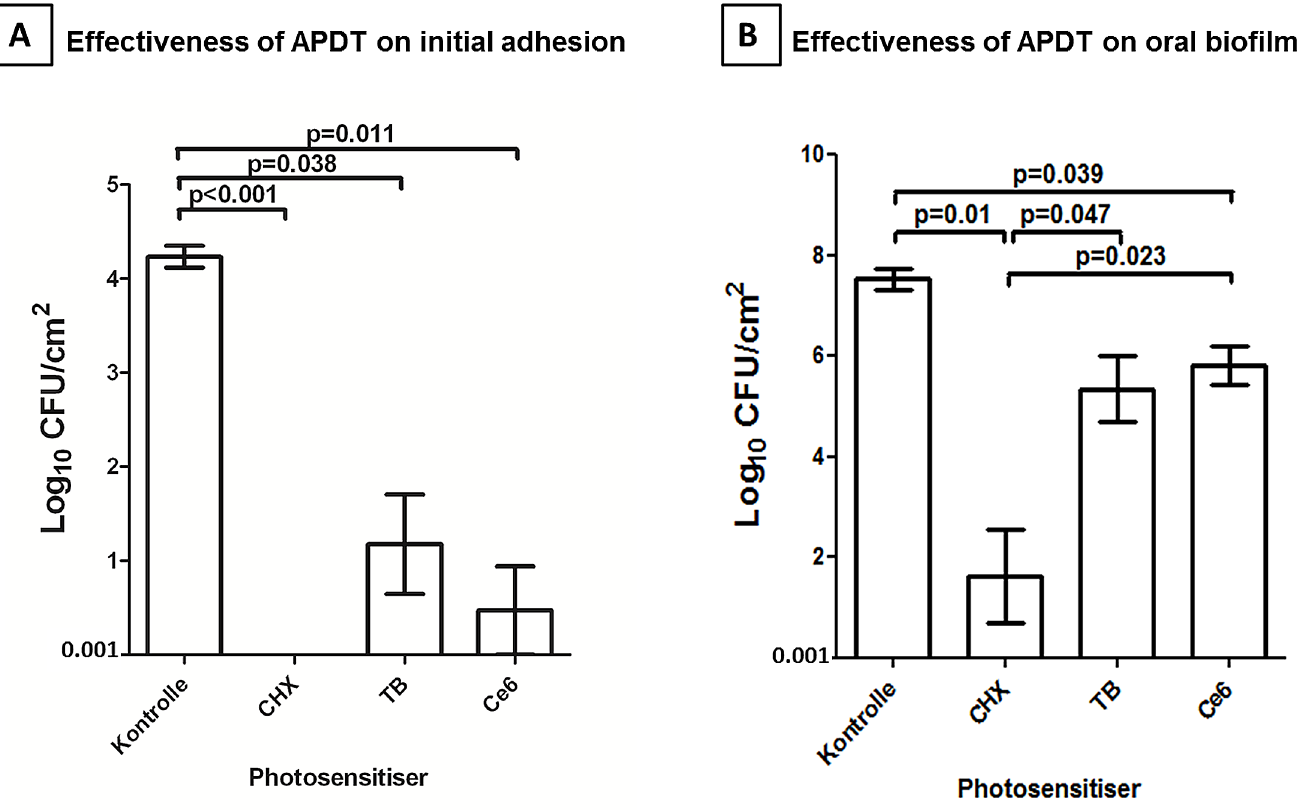
Fig 3. Diagram of the colony forming units (CFUs) depicting the effect of photodynamic therapy using visible light (VIS) plus water-filtered infrared-A (wIRA) against oral microorganisms during initial adhesion (A) and biofilm formation (B), respectively. The photosensitizers toluidine blue (TB) and chlorine e6 (Ce6) were applied (100 μ g/ml) ex vivo onto the oral microorganisms after 2 hours (h) or 3 days (d) of in situ cultivation, respectively. An untreated specimen and a chlorhexidine-treated (CHX) specimen served as negative and positive controls. A log 10 scale per square centimeter (log 10 / cm 2 ) indicates the CFUs. The p-values (t-test) of the significantly different data are depicted above.